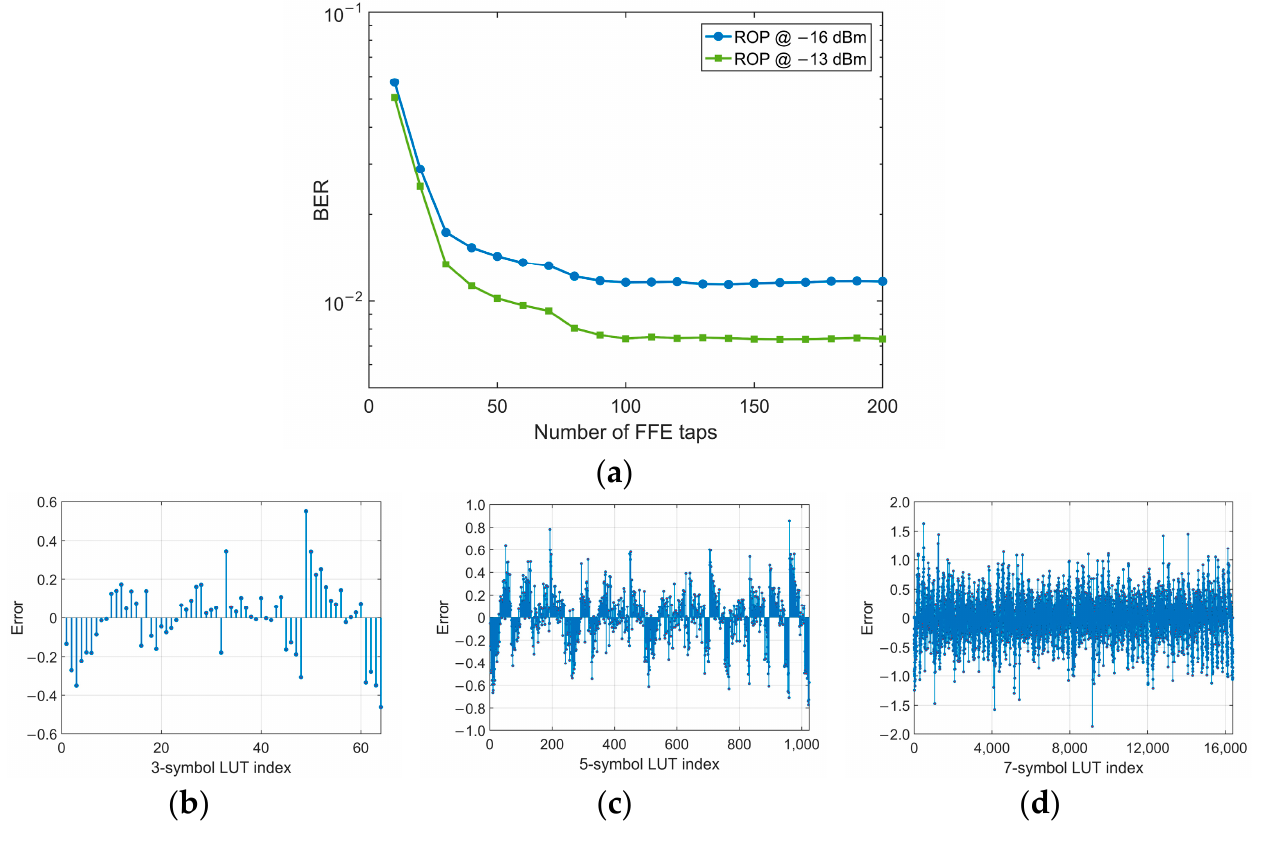
Figure 6. ( a ) BER performance as a function of the number of FFE taps; LUTs with memory length 2 M + 1 = 3, 5 and 7 for ( b ), ( c ) and ( d ) respectively.